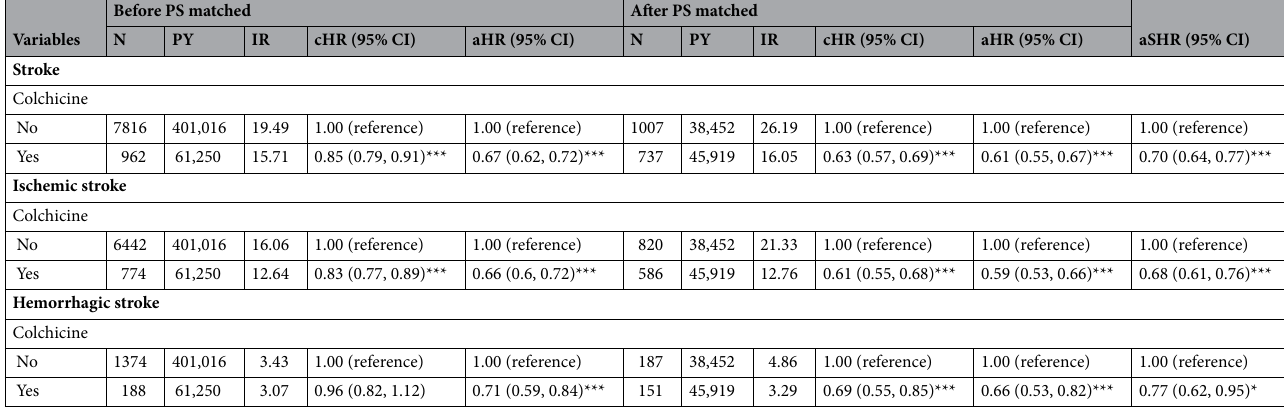
Table 2. Incidence and hazard ratios of stroke in DM patients treated with and without Colchicine. aHR adjusted for age, sex, hypertension, hyperlipidemia, hypoglycemia, obesity, gout, pneumonia, hepatitis B, hepatitis C, liver cirrhosis, Allopurinol, Benzbromarone, nsaid, Oralsteroid, Antithrombotic, adapted Diabetes Complications Severity Index, aDCSI and inpatient day. PS, propensity score; N, number of event; PY, person- years; IR, incidence rate, per 1000 person-years; cHR, crude hazard ratio; aHR, adjusted hazard ratio; aSHR: adjusted subdistribution hazard ratio; CI, confidence interval. *p < 0.05, ***p <